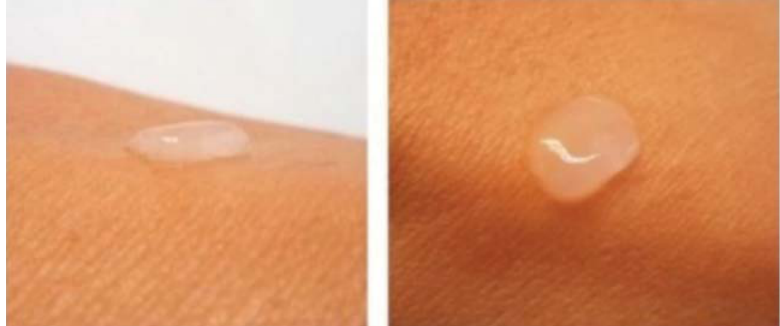
Figure 5- Clinical appearance of the developed dermal-epidermal skin